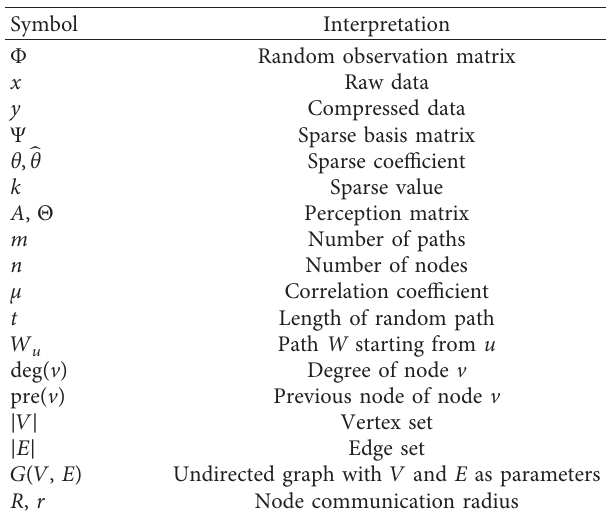
Table 1: Symbols and meanings.